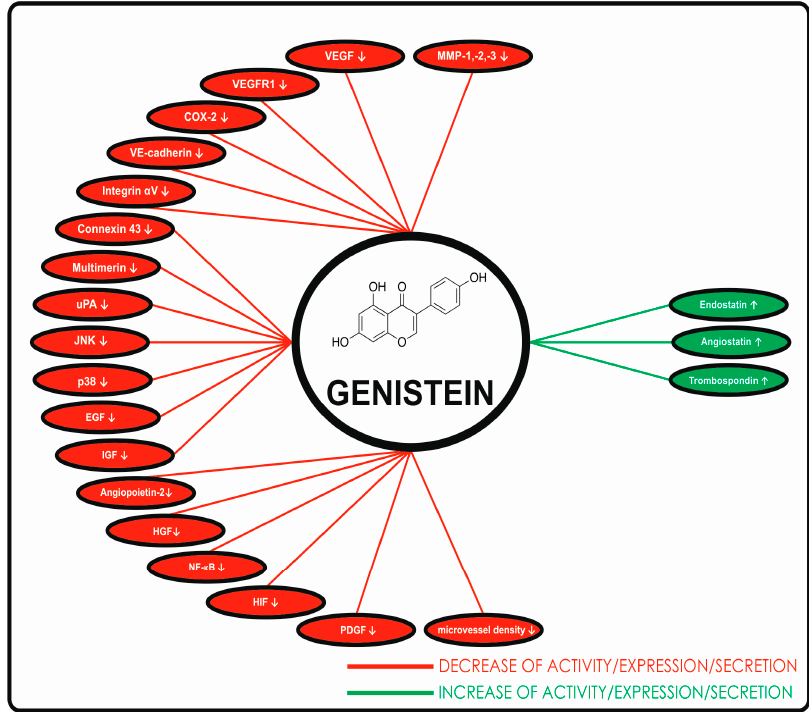
Figure 1. Molecular targets of genistein on endothelial cells. Adopted from Varinska et al. [89]. ( ↓ decrease; ↑ increase).